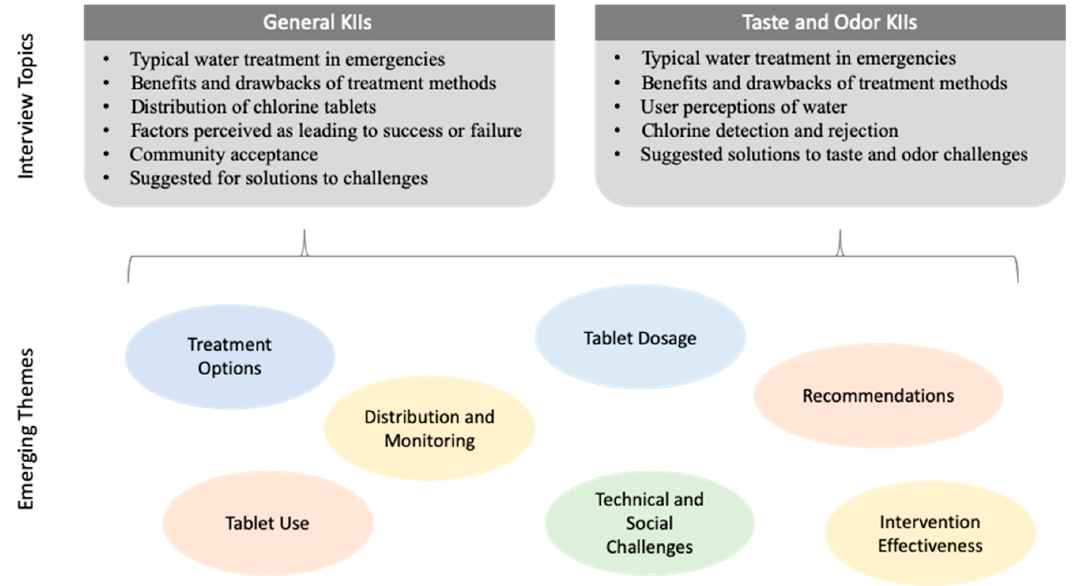
Figure 1 . Key informant interview question topics and emerging themes . Figure 1. Key informant interview question topics and emerging